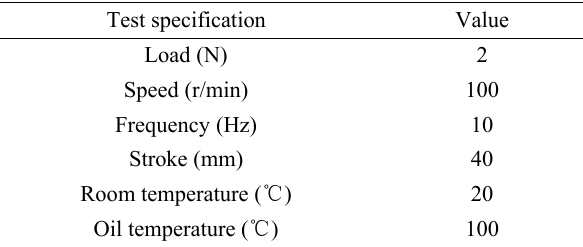
Table 3 Tribological testing parameters.